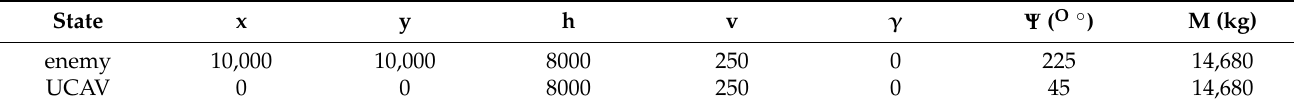
Table 3. Initial state values of UCAV and